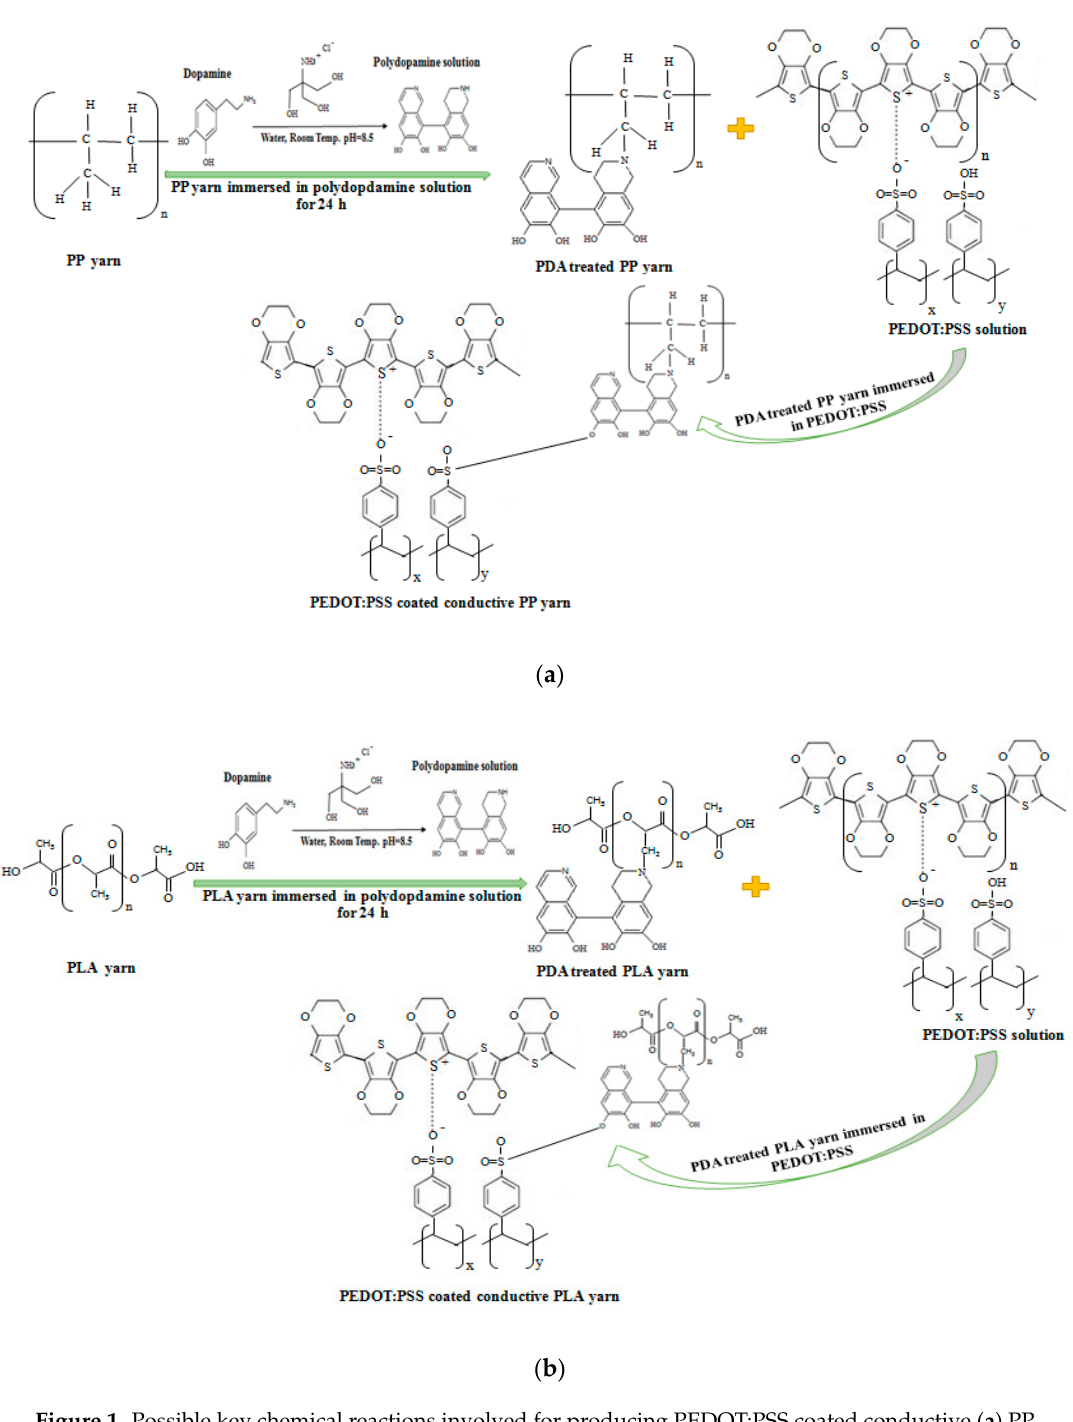
Figure 1. Possible key chemical reactions involved for producing PEDOT:PSS coated conductive ( a ) PP and ( b ) PLA yarn .